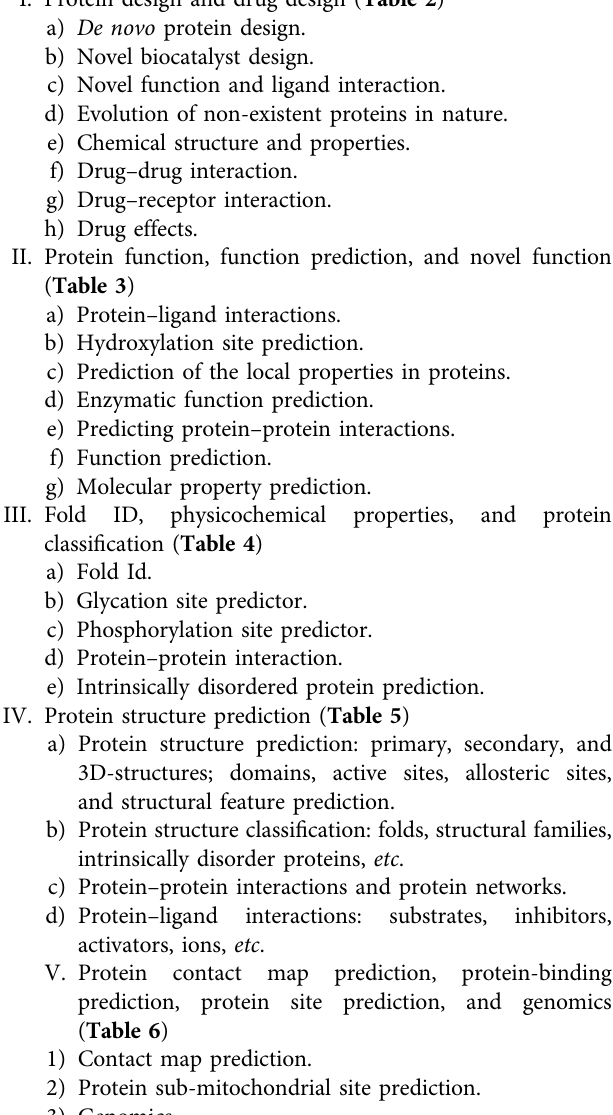
Frontiers in Bioengineering and Biotechnology |